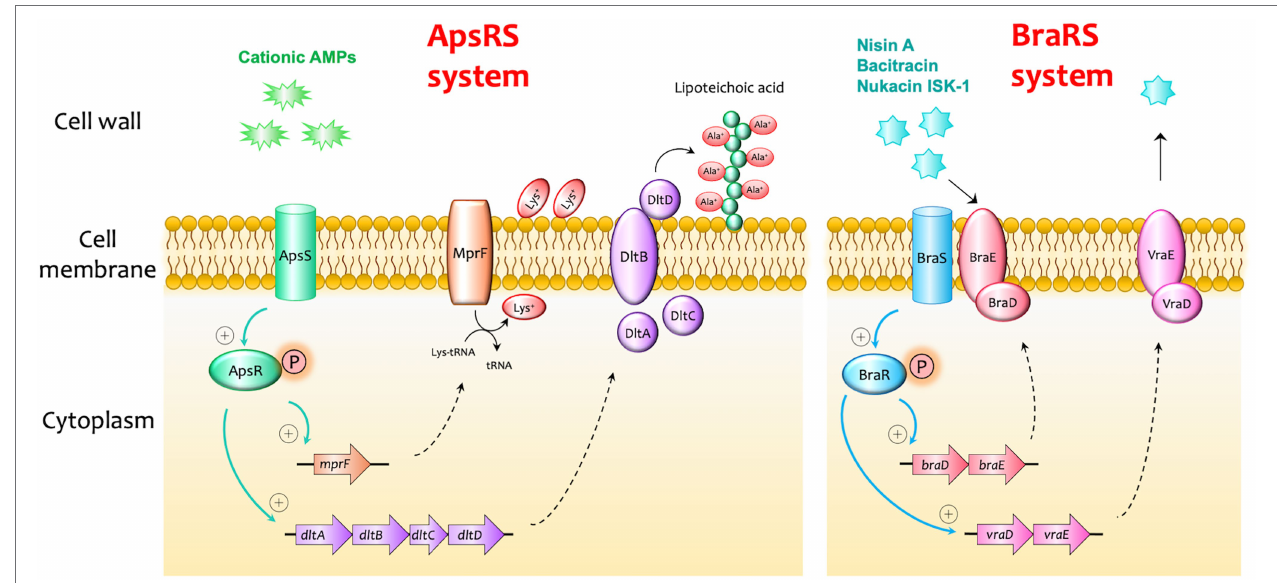
FIGURE 5 | Examples of bacteriocin resistance mechanisms in Staphylococcus aureus . I. In the ApsRS system, the sensing of cationic antimicrobial peptides (AMPs) results in the autophosphorylation of ApsS, followed by the phosphorylation of ApsR. The phosphorylated ApsR can bind to the upstream regions of mprF and dltABCD , increasing the expression of these factors. MprF is associated with the addition of lysine to phosphatidylglycerol in the cell membrane, and DltABCD is associated with the addition of alanine to teichoic acids on the cell wall. Amino acid incorporation causes a shift to a weak negative charge on the cell surfaces and makes the cell less sensitive to cationic AMPs. II. In the BraRS (NsaRS)/BraDE system, sensing of nisin A by BraDE results in the autophosphorylation of BraS, followed by the phosphorylation of BraR. The phosphorylated BraR can bind to the upstream region of vraDE , giving rise to the increased expression of an ABC transporter VraDE which expels the AMPs from the